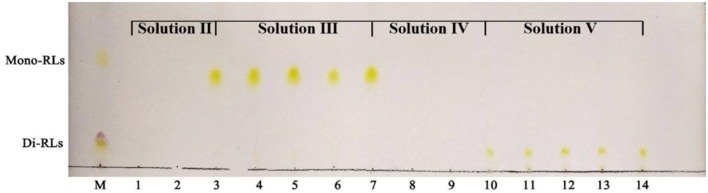
TLC analysis of mono- and di-rhamnolipids separated by silica gel column chromatography. M, commercial rhamnolipids; Lanes 1,2, the samples eluted by solvent II; Lanes 3–7, the samples eluted by solvent III; Lanes 8,9, the samples eluted by solvent IV; Lanes 10–14, the samples eluted by solvent V.